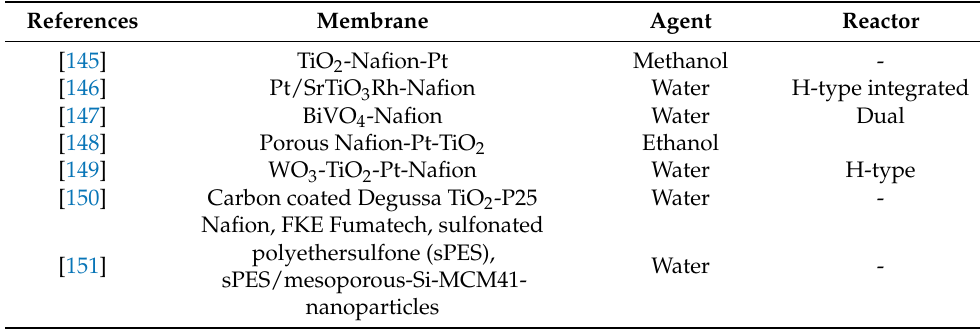
Table 6. Summary of photoelectrochemical electrolysis for hydrogen production.